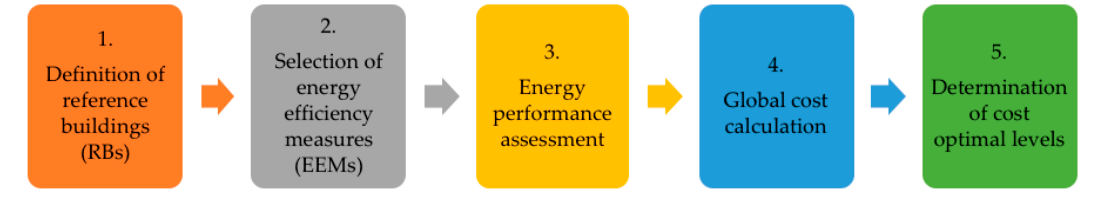
Figure 1. The multi-step methodology for COA applications.